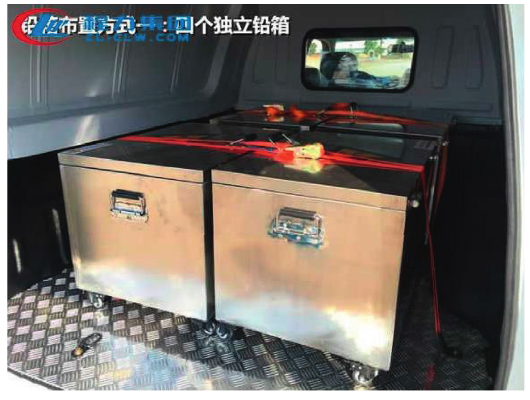
Figure 1: Radioactive material carrier 1.